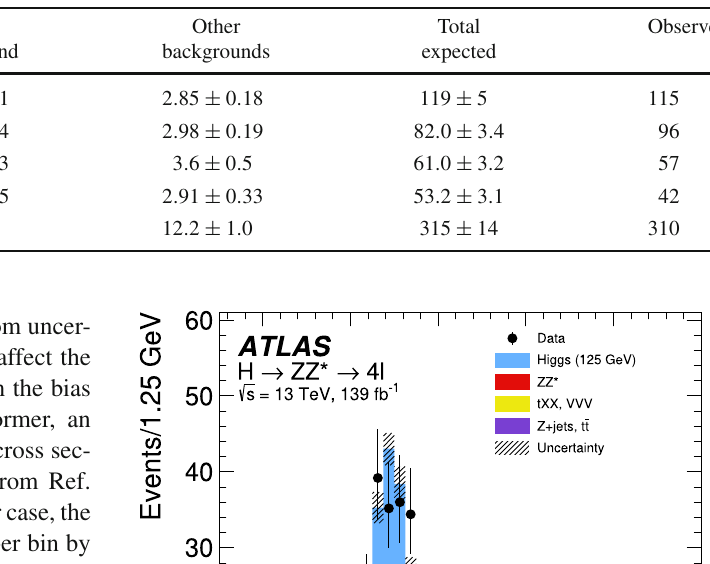
Higgs boson events and the estimated background yields is compared with the data. Combined statistical and systematic uncertainties are included for the predictions (see Sect. 8)